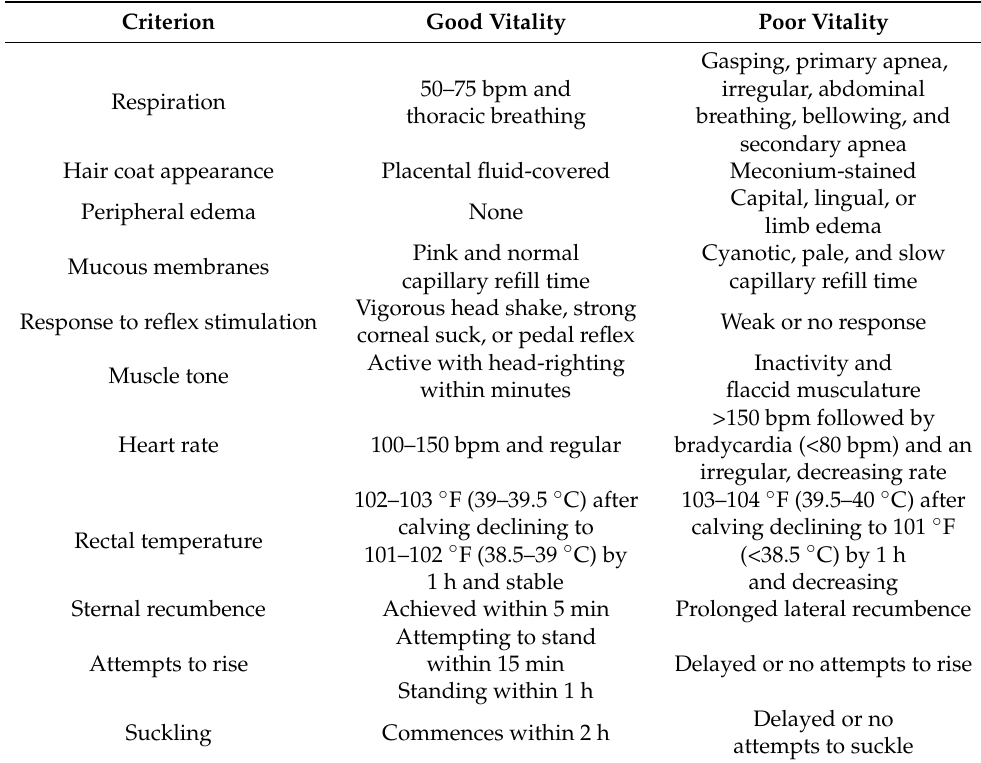
Table 6. Calf vitality score sheet recommended by Mee